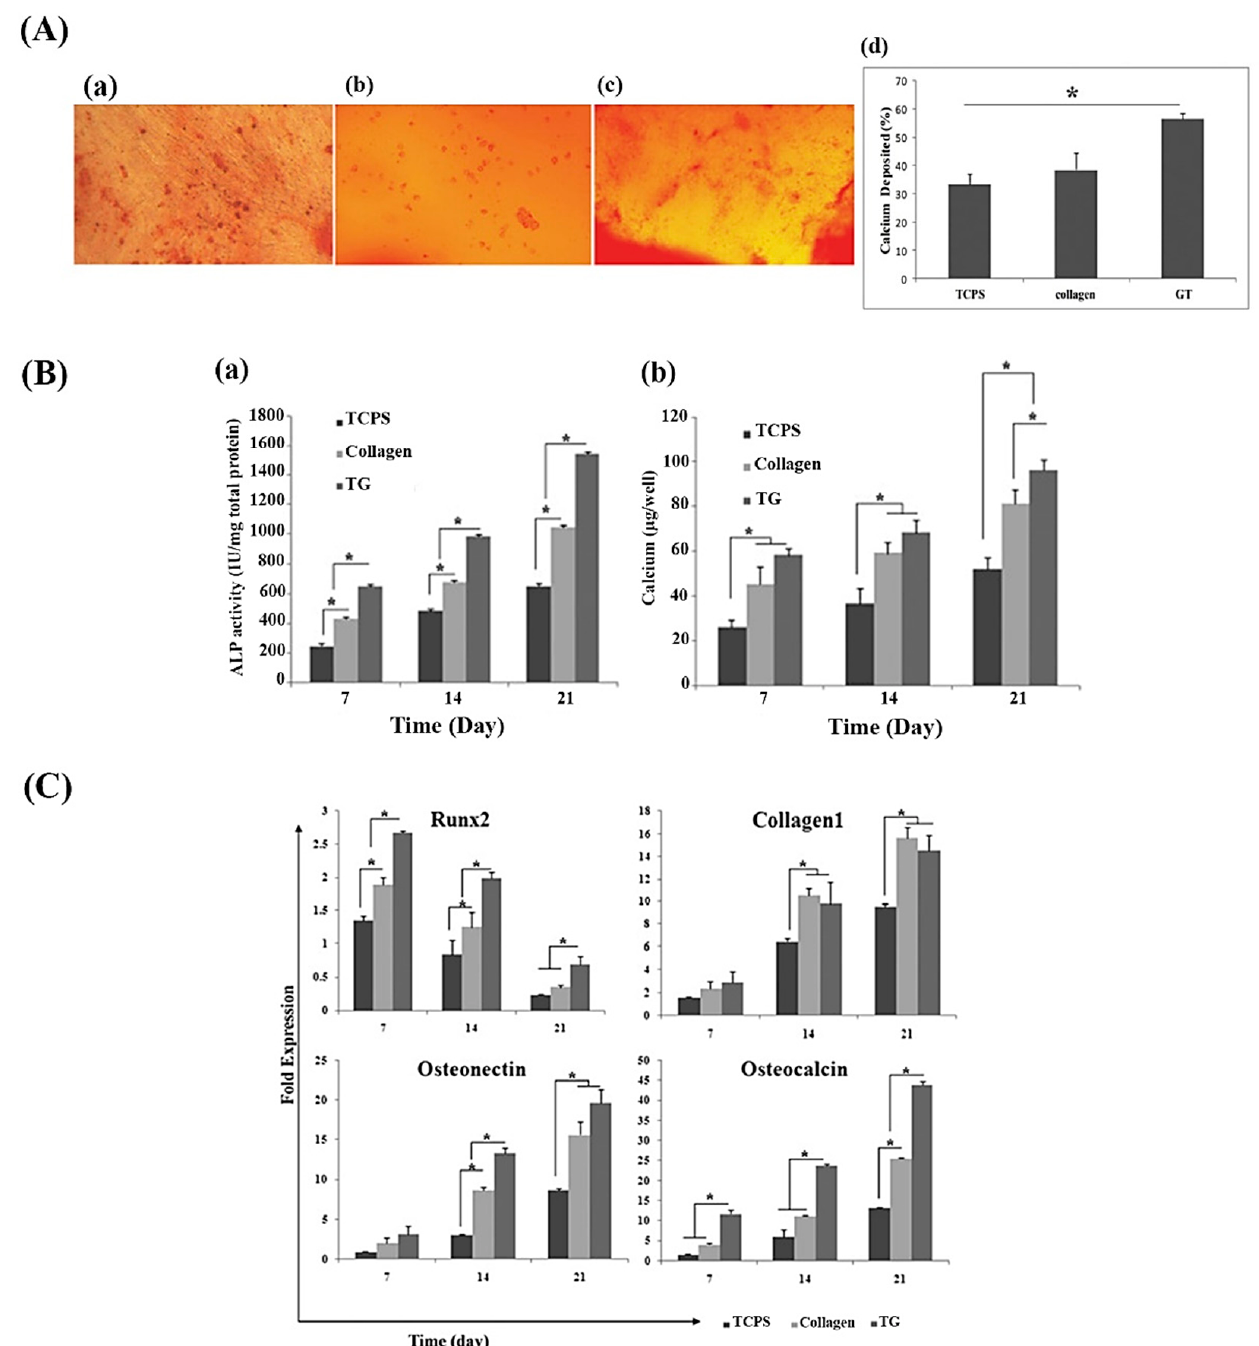
Figure 5. ( A ) Microscopic photographs of differentiated human adipose-derived mesenchymal stem cells cultured on tissue culture polystyrene (TCPS) ( a ), collagen ( b ), and gum tragacanth (GT) ( c ) stained with Alizarin Red S after 21 days of culturing in the osteogenic induction medium (Magnification × 40), as well as the graph ( d ) showing the quantified values for calcium deposition of different groups. ( B ) Alkaline phosphatase (ALP) activity of ( a ) and calcium content ( b ) of the stem cells cultured on TCPS, collagen, and GT after 7, 14, and 21 days of culturing in the osteogenic differentiation medium (asterisks significant difference between the groups at p < 0.05). ( C ) Real-time PCR data exhibiting relative expression of osteogenic-related genes including Runx2, collagen type 1, osteonectin, and osteocalcin in the stem cells cultured on TCPS, collagen, and GT at day 7, 14, and 21 (* refers to the significant difference between the groups at p < 0.05). Reproduced with permission from [16], Copyright 2016, Elsevier.